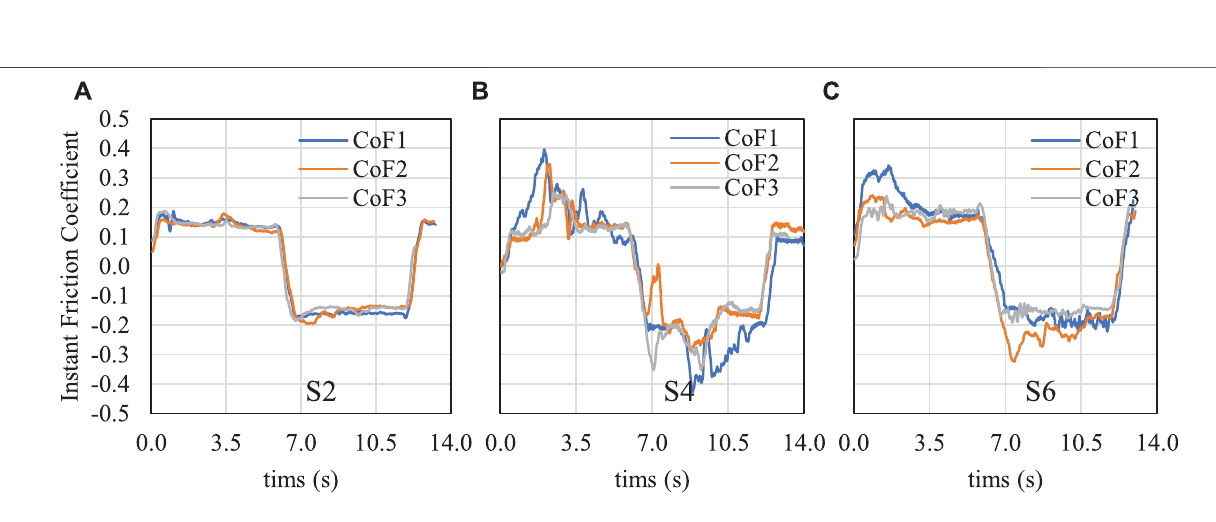
Frontiers in Energy Research |